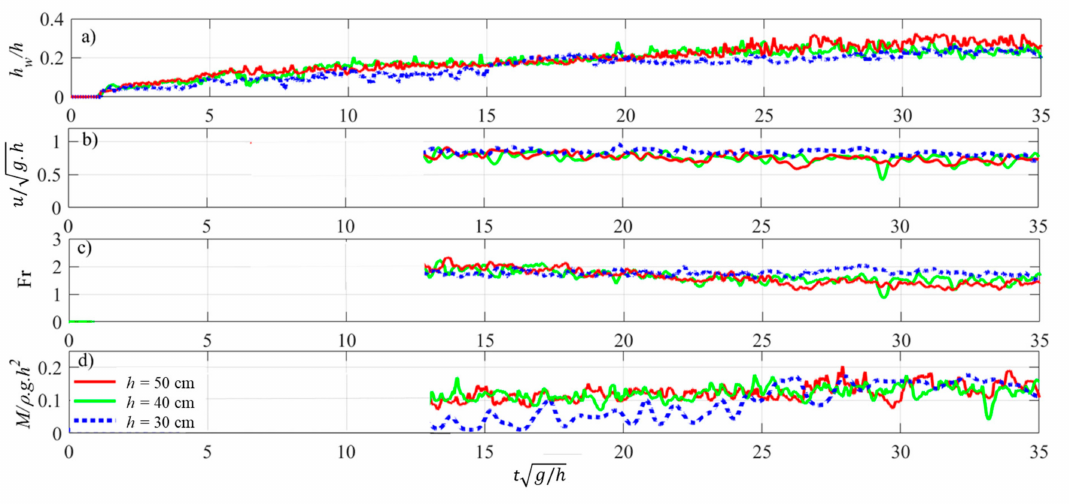
Figure 8. Dry bed surge characteristics at x = 5.5 for h = 30, 40, 50 cm. ( a ) water surface time-history profile (WG3), ( b ) flow velocity time-history, ( c ) Froude number time-history and ( d ) momentum flux